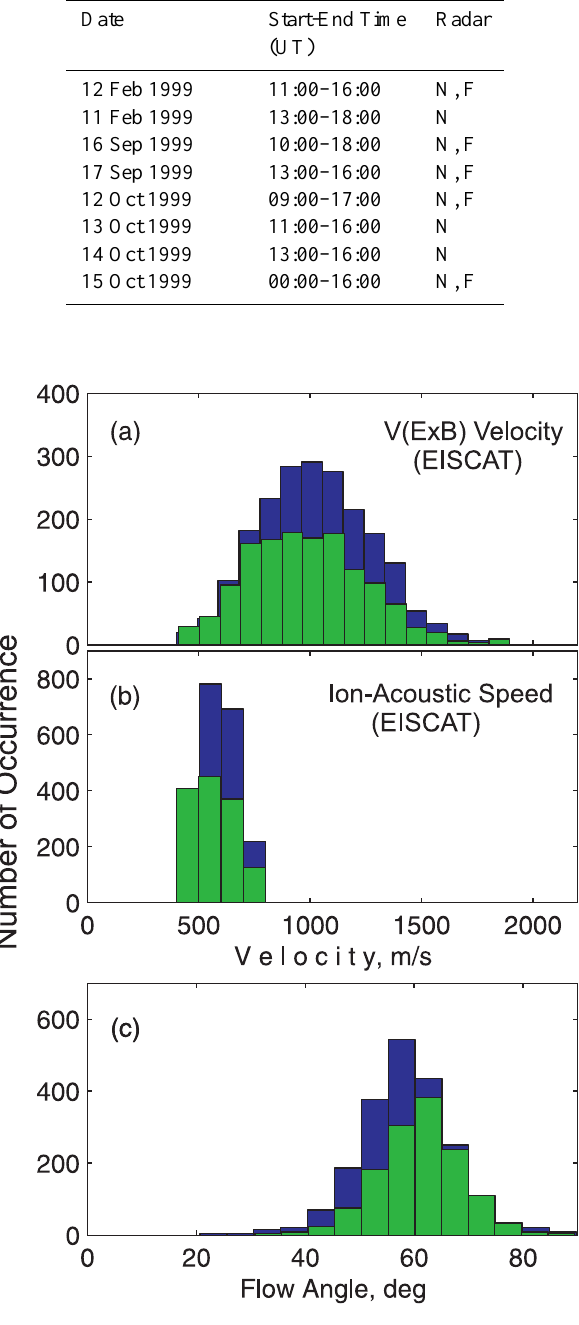
Fig. 3. Histogram distributions (a) for the E × B velocity magni- tude, (b) the ion-acoustic speed at 111km and (c) the flow angles of observations for the Norway and Finland radars in all events se- lected for the analysis. The total number of points is 2085 for the Norway and 1379 for the Finland radars. Data for the Norway (Fin- land) radar are shown by blue (green)